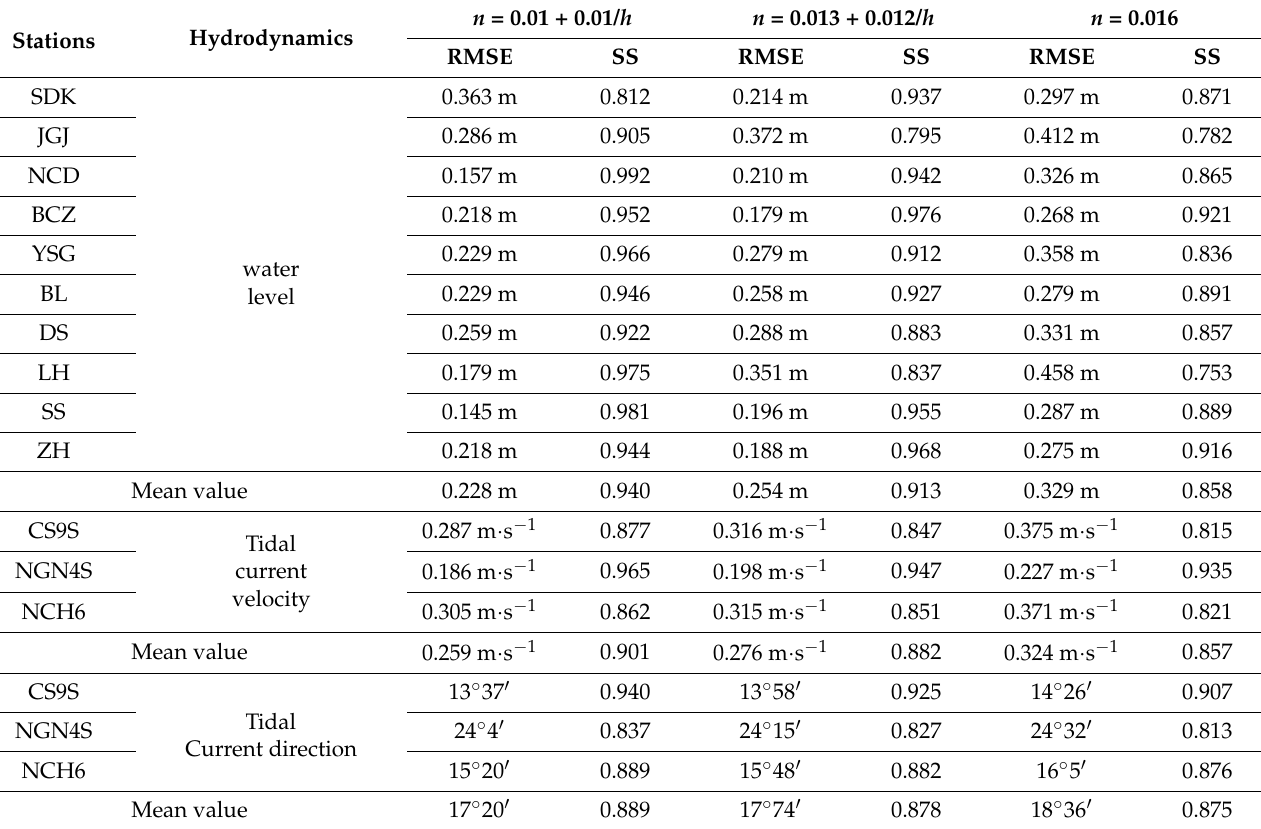
Table 1. Model performance (RMSE and SS) in simulating hydrodynamics when using different roughness estimations. Stations Hydrodynamics